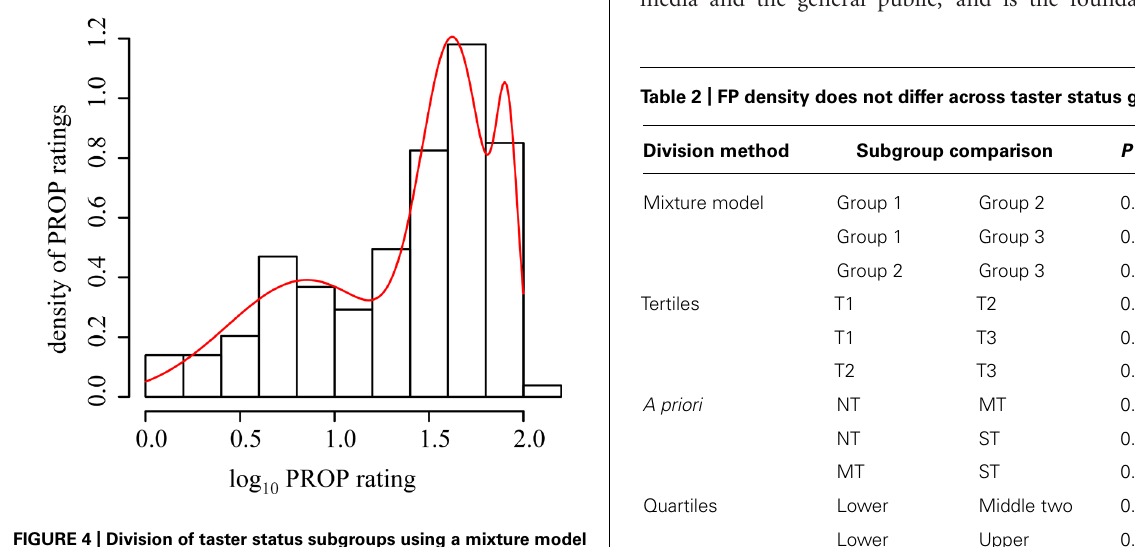
FIGURE 4 | Division of taster status subgroups using a mixture model of three normal distributions. Frequency histogram of logarithm base 10 of PROP overlaid with the mixture density overlaid in red. Data statistically divided into the three groups, with group membership assigned via their posterior